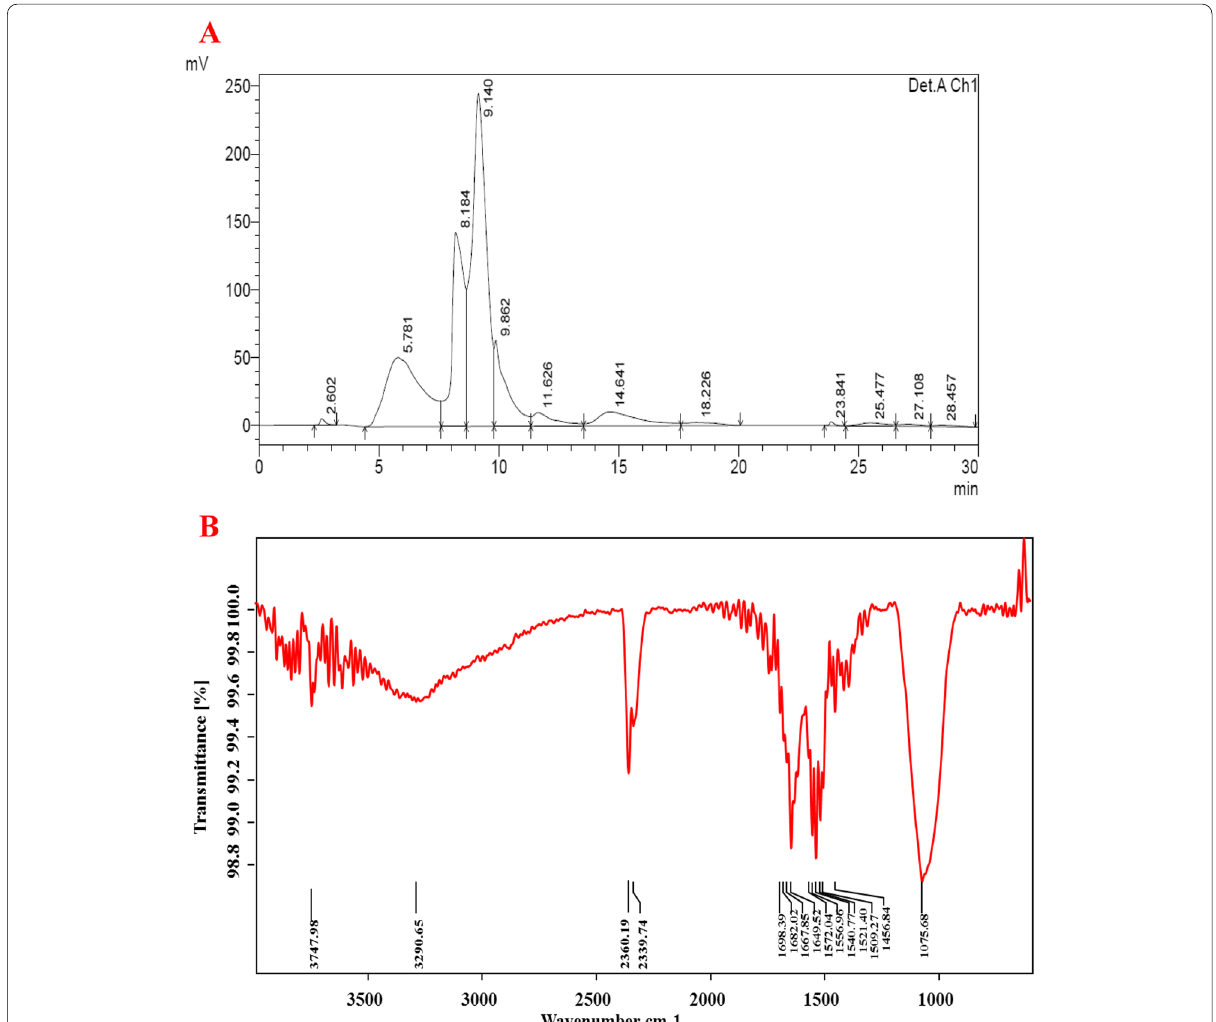
Fig. 3 HPLC analysis of extracted proteins ( A ); FT-IR analysis of extracted protein for the protease enzyme-producing bacterium of Bacillus thuringiensis ( B